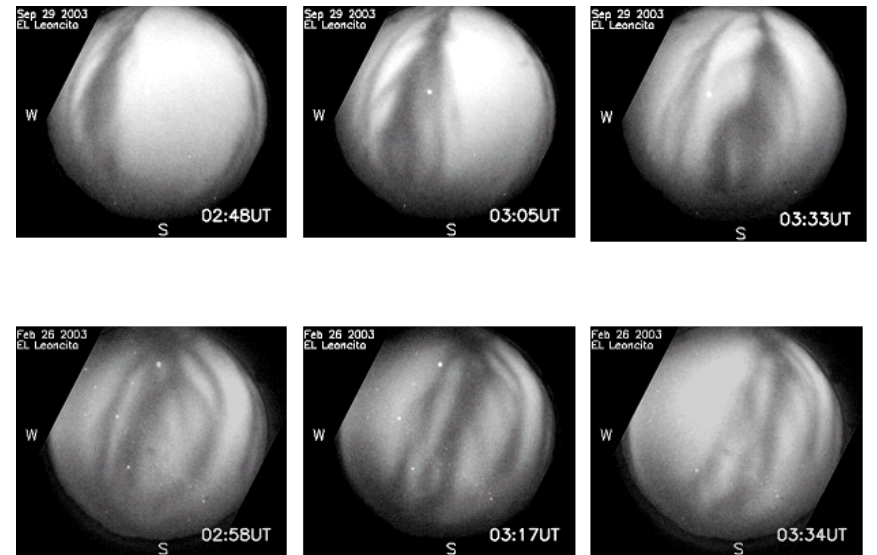
Fig. 3. Examples of eastward moving 630.0nm airglow depletions during a 1-h period for two of the cases shown in Fig. 2: 29 September 2003 (top panel); and 26 February 2003 (bottom panel).